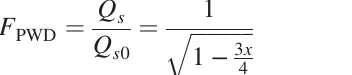
τ 2 . 8 ), above transition, without such that f r r b ¼